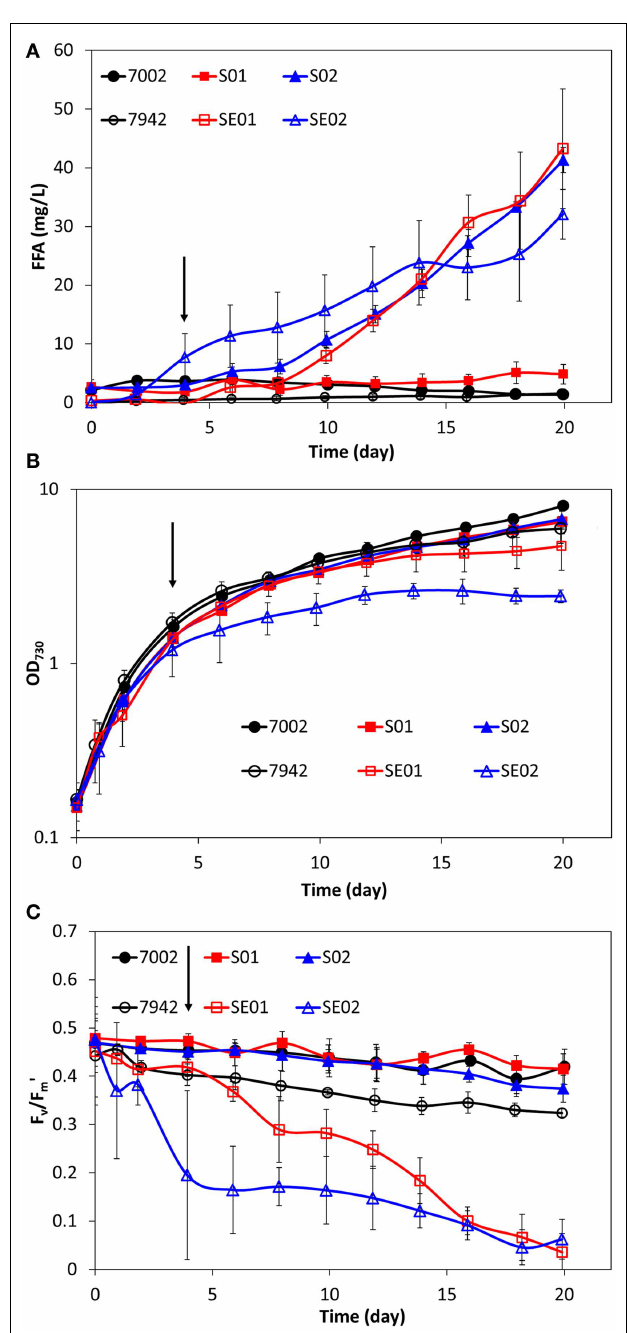
FIGURE 1 | Comparison of extracellular FFA concentration (A), cell concentration (B), and photosynthetic yields (C) during FFA production in two cyanobacterial hosts: S. elongatus PCC 7942 and Synechococcus sp. PCC 7002 .Wild-type strains are illustrated with black circles (7942 – open, 7002 – filled). Strains with gene knockout of the FFA-recycling acyl-ACP synthetase/long-chain-fatty-acid CoA ligase ( aas / fadD ) are illustrated with red squares (SE01 – open, S01 – filled). Strains with gene knockout of the FFA-recycling gene and ‘tesA expression are illustrated with blue triangles (SE02 – open, S02 – filled). Addition of IPTG is indicated by the arrows (100h). All data are averages of at least three biological replicates with error bars indicating the standard